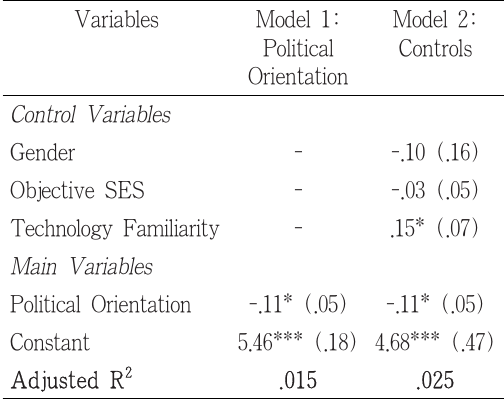
<Table 3> Results of the regression analysis: The evaluation of the potential value of AI